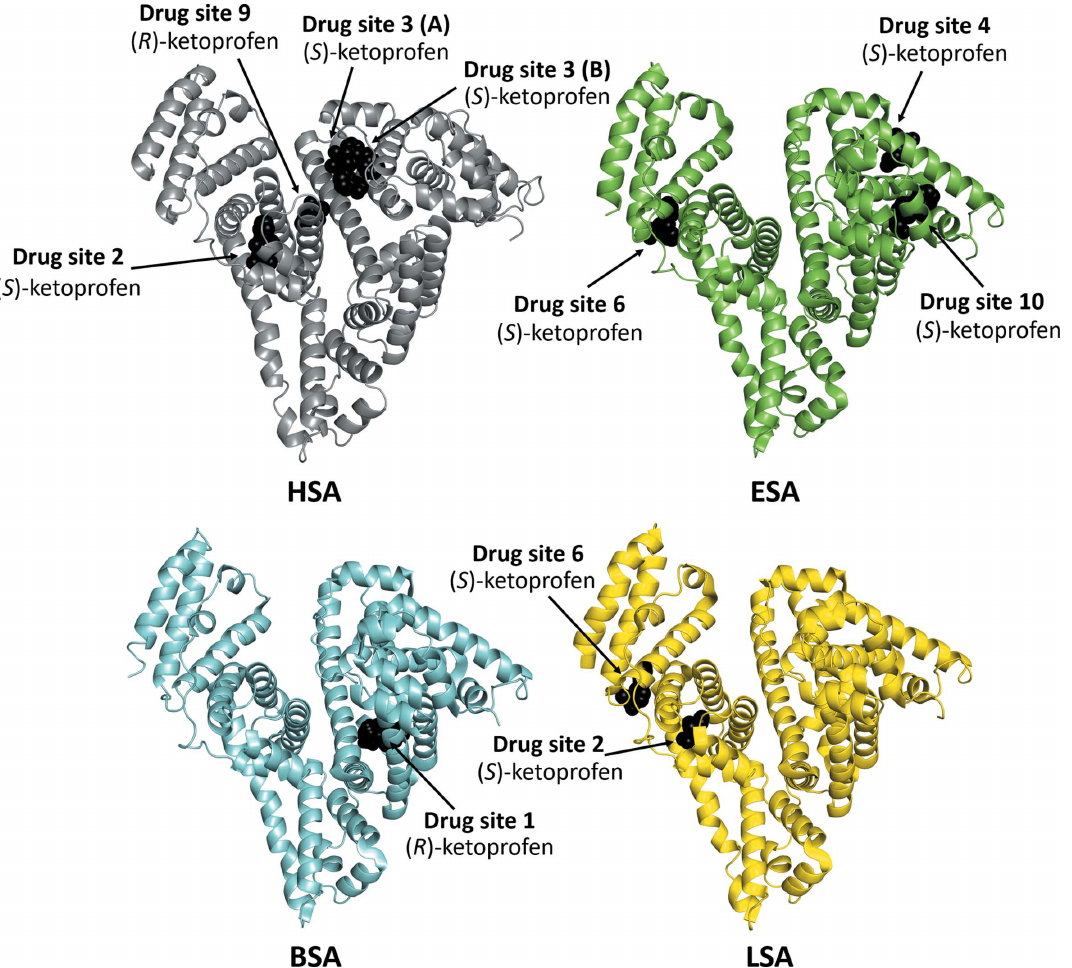
Figure 4 Ketoprofen binding sites in mammalian serum albumins. Structures of ketoprofen complexes with HSA (PDB entry 7jwn), ESA (Czub et al. , 2020; PDB entry 6u4r), BSA (Castagna et al. , 2019; PDB entry 6qs9) and LSA (Zielinski et al. , 2020; PDB entry